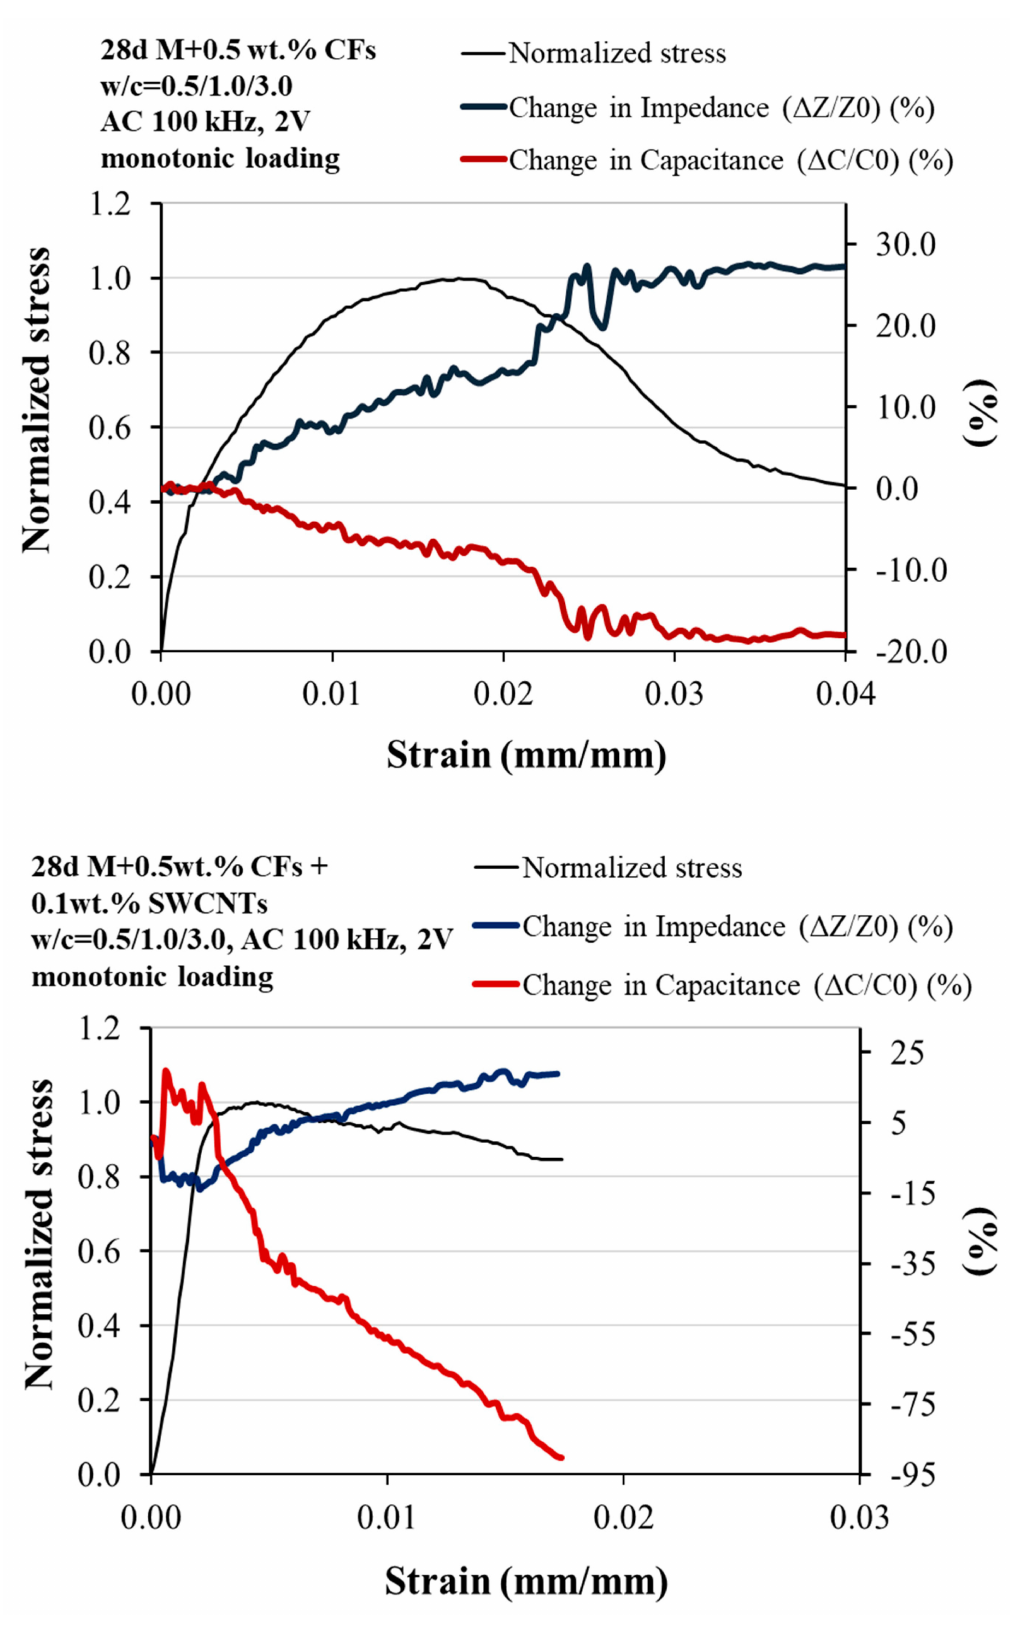
Figure 7. Piezoresistive response under monotonic compressive loading of 28-d plain, reinforced with 0.1 wt.% SWCNTs, with 0.5 wt.% CFs and hybrid-modified